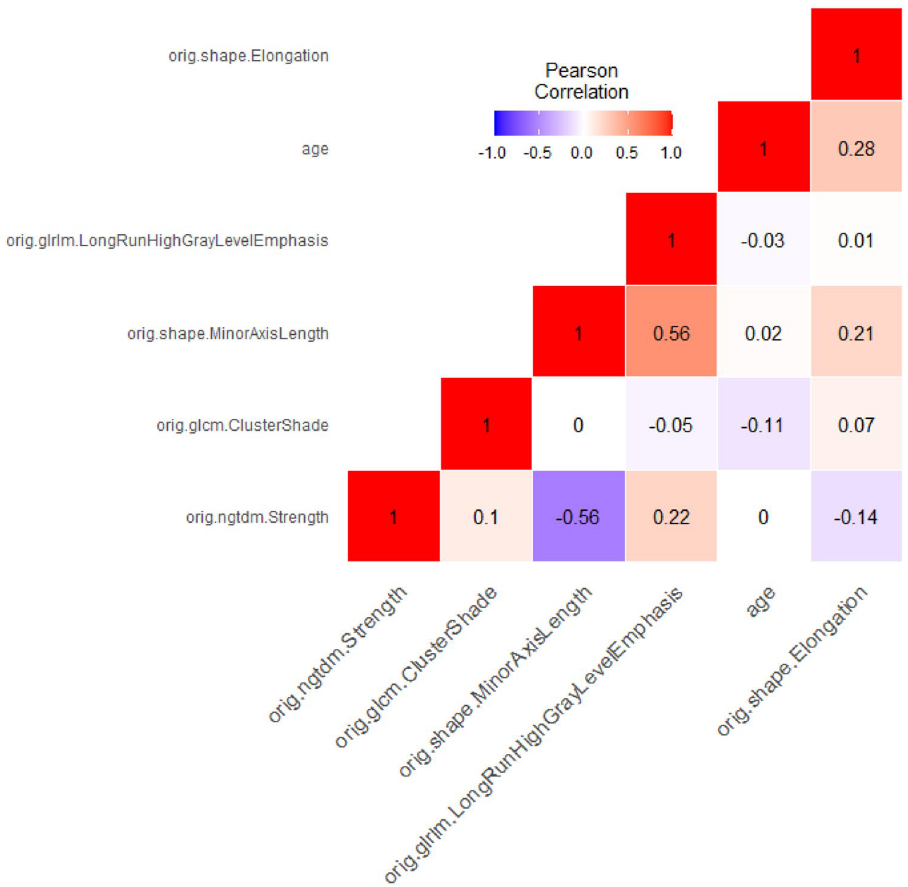
Figure 2. Pearson Correlation for selected GBM model with 6 features.